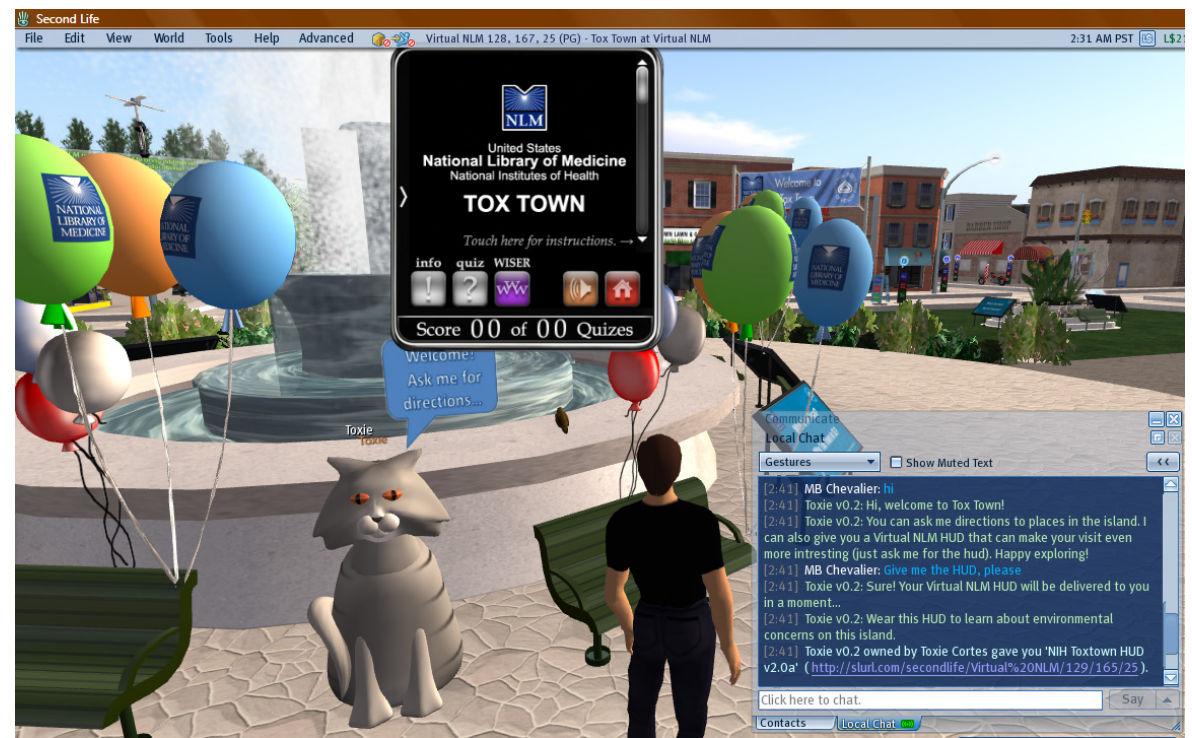
Figure 8 . The teleport map in Tox Town’s Welcome